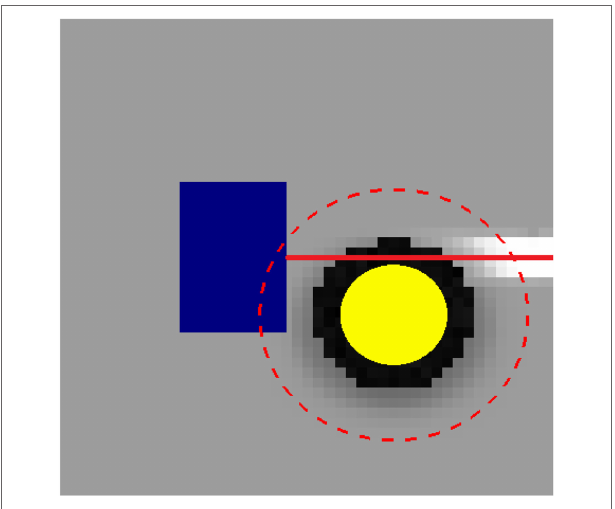
FiGUre 5 | Human empowerment (in grayscale: dark—low, bright—high) dependent on the robot’s position. In this simulation, a laser (indicated by the red line) blocks the human’s movement, but the laser can be occluded by the robot body. Thus, Human empowerment is the highest for robot positions toward the right wall where the robot blocks the laser and thereby allows the human a greater range of